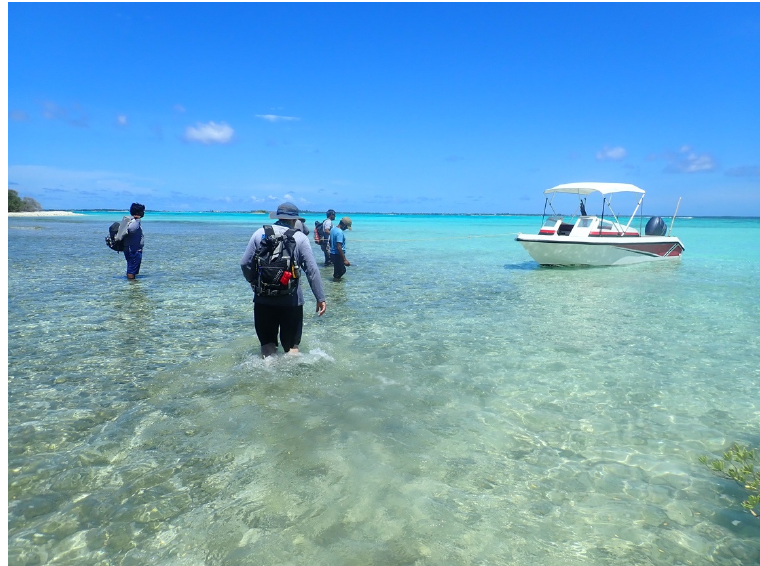
Figure 6. The MAHS field team carrying survey gear from a recently surveyed island back to the boat in the Maldives. Heritage survey and documentation for many remote islands in Southern Asia are logistically challenging and sometimes requires extraordinary efforts to access sites. (Photo Credit P. Daly.)